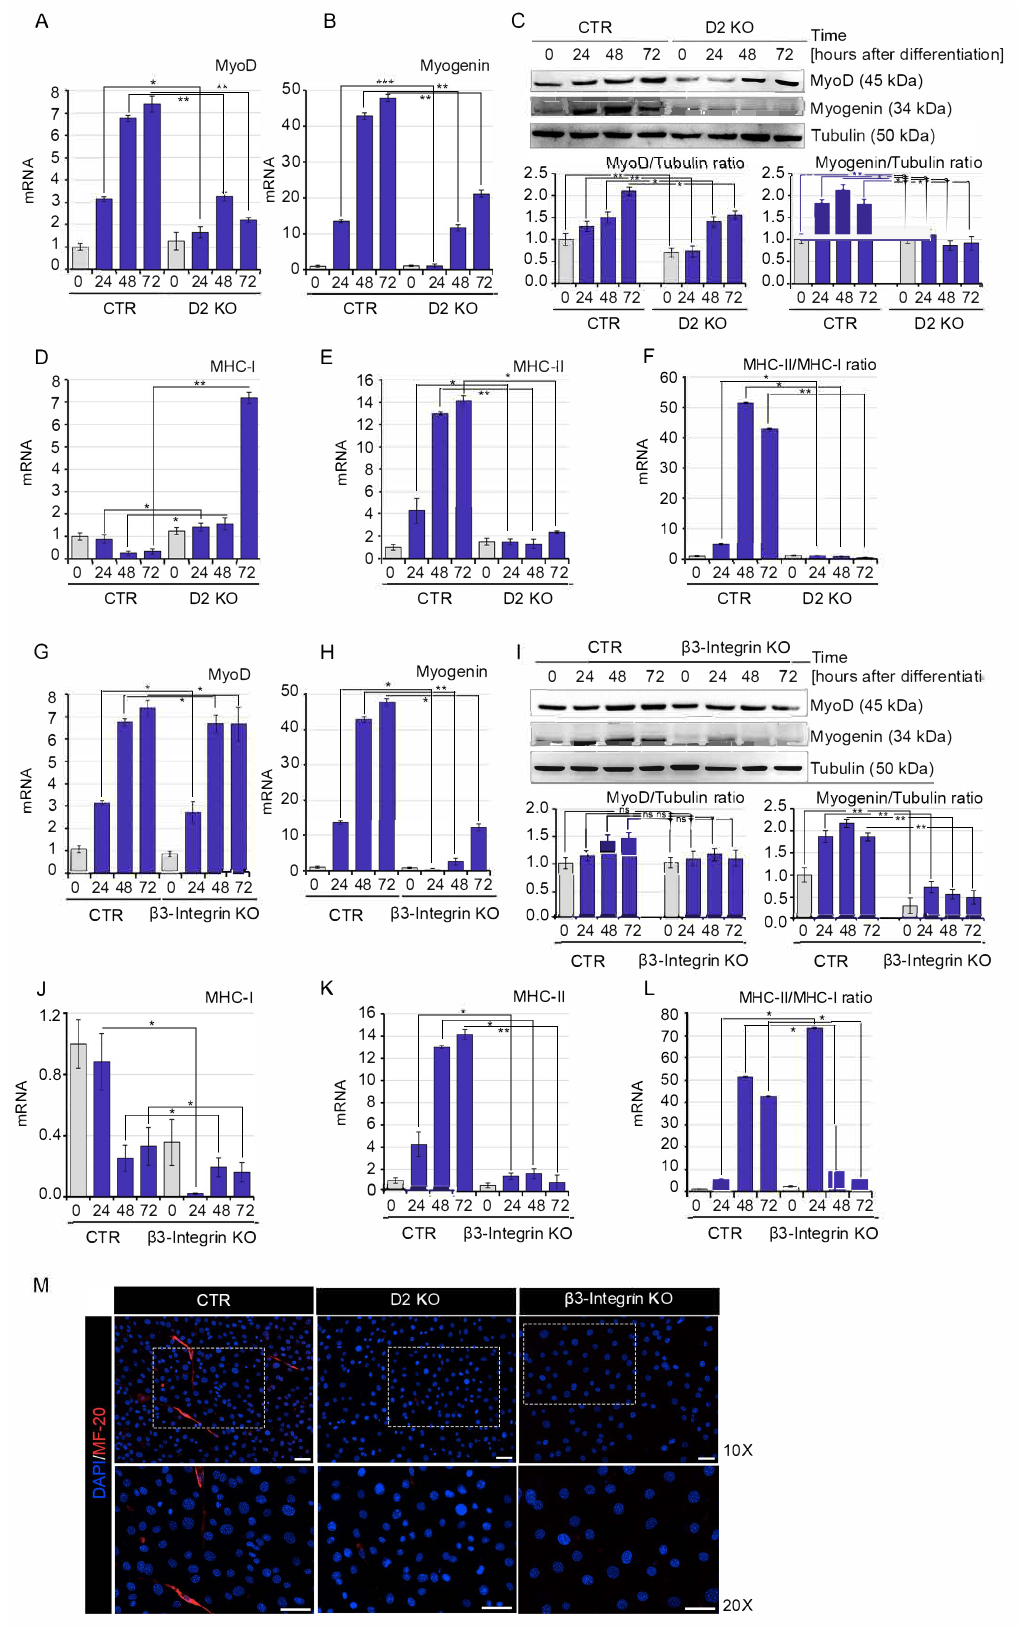
Figure 3. D2 and β 3-Integrin knock-out block TH-mediated myogenic differentiation. ( A , B ) MyoD and Myogenin expression was evaluated by real-time PCR in D2 KO and CTR cells grown in differentiative conditions at 0, 24, 48 and 72 h after